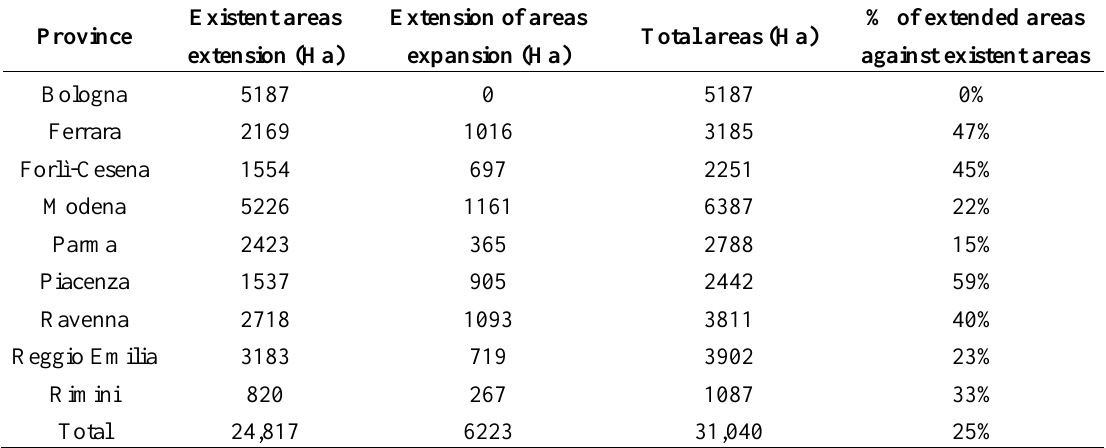
Table 5. Industrial settlements in Emilia-Romagna, by Province (data source: Ervet and MOAPnet (Monitoraggio Aree Produttive di Modena)).